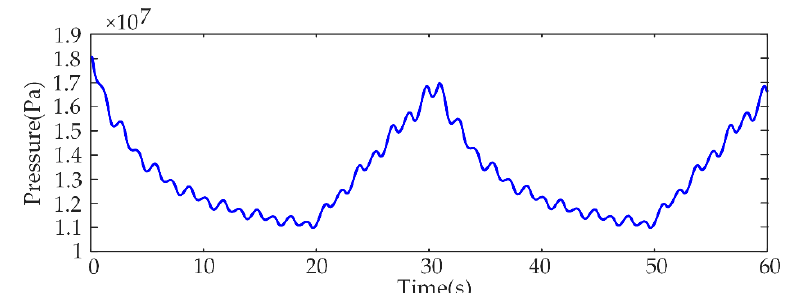
Figure 6. Accumulator pressure under regular incident waves.